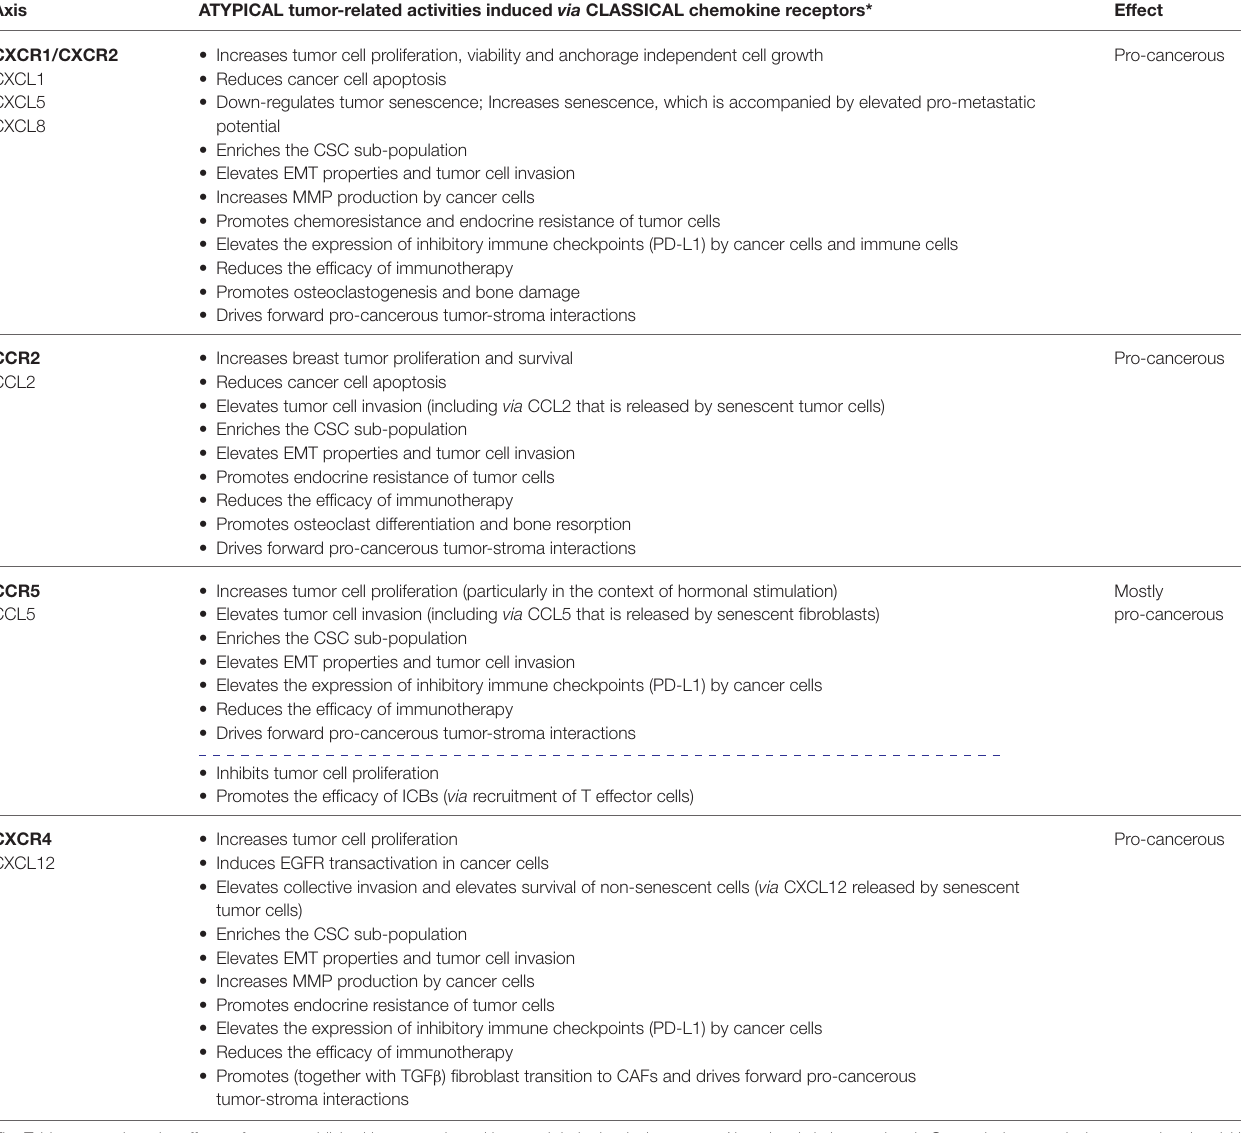
TABLE 1 | Atypical chemokine functions in cancer, mediated by axes of chemokines and classical chemokine receptors.